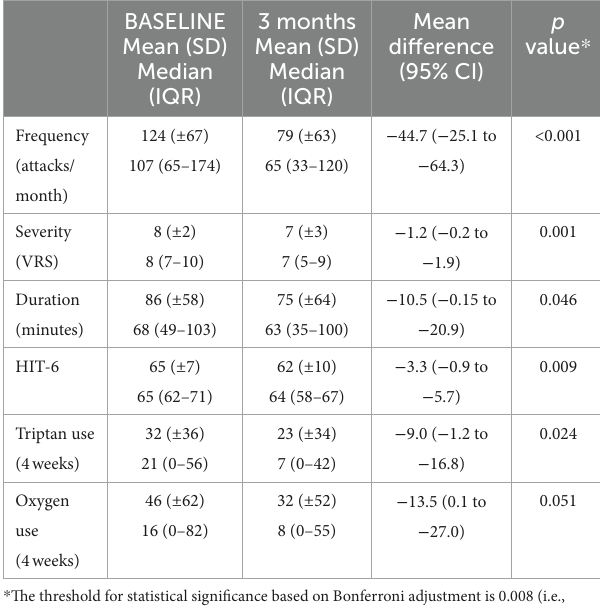
TABLE 2 Non-invasive vagus nerve stimulation using the gammaCore ® device in chronic cluster headache.